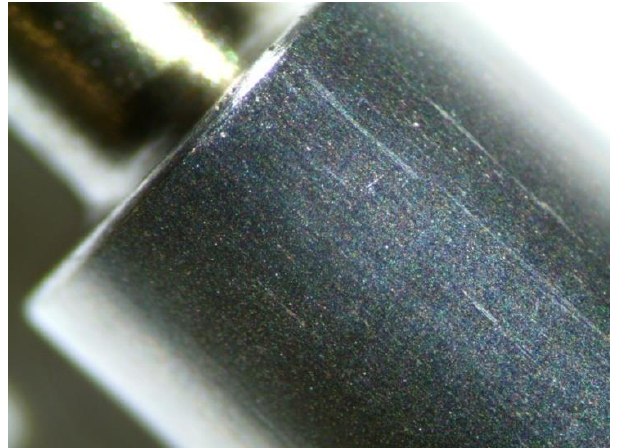
Fig. 4. Friction wear traces on the needle